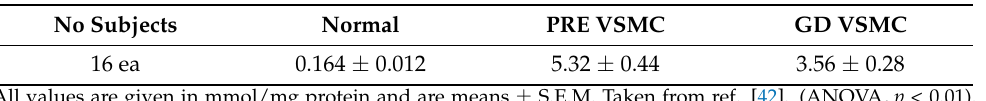
Table 2. HNE Levels in Umbilical Vascular Smooth Muscle Cells (VSMC) taken from Preeclamptic (PRE) and Gestational Diabetic (PD) Women at Term